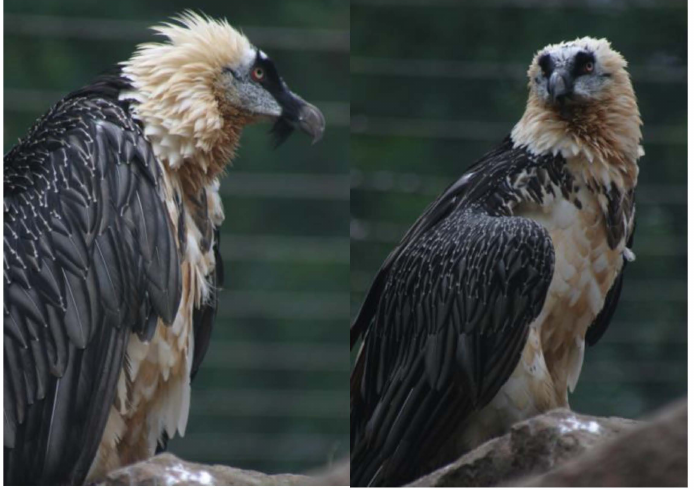
Figure 1. The bearded vulture ( Gypaetus barbaticus ) has a genetically anchored addiction to taint his feathers with red ochre